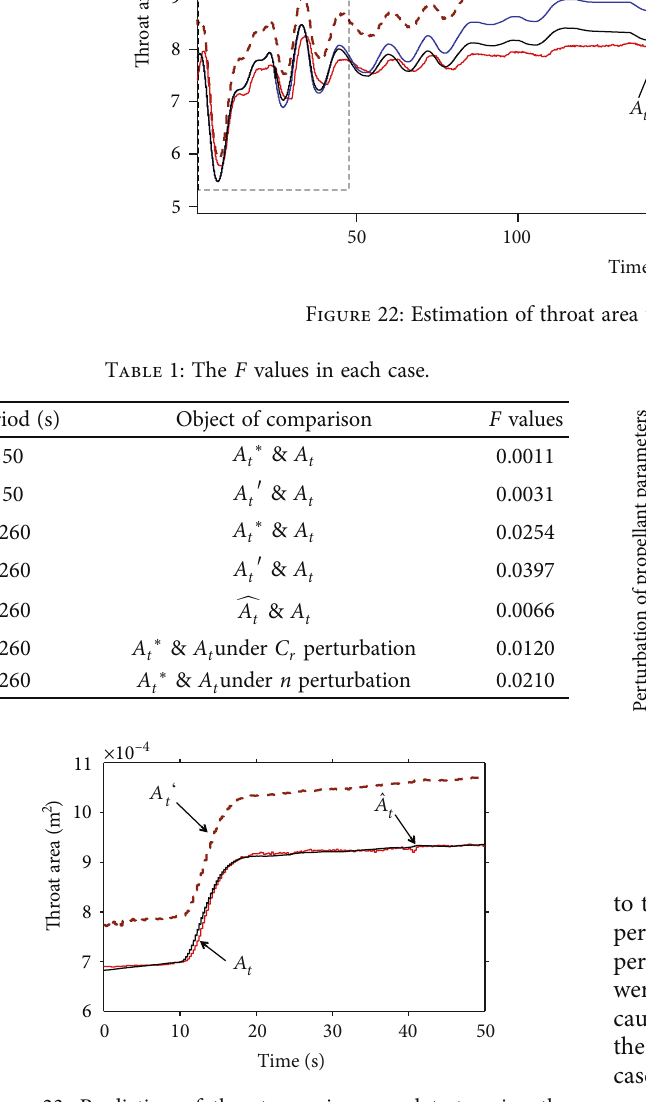
Figure 23: Prediction of throat area in ground tests using the throat deformation model.